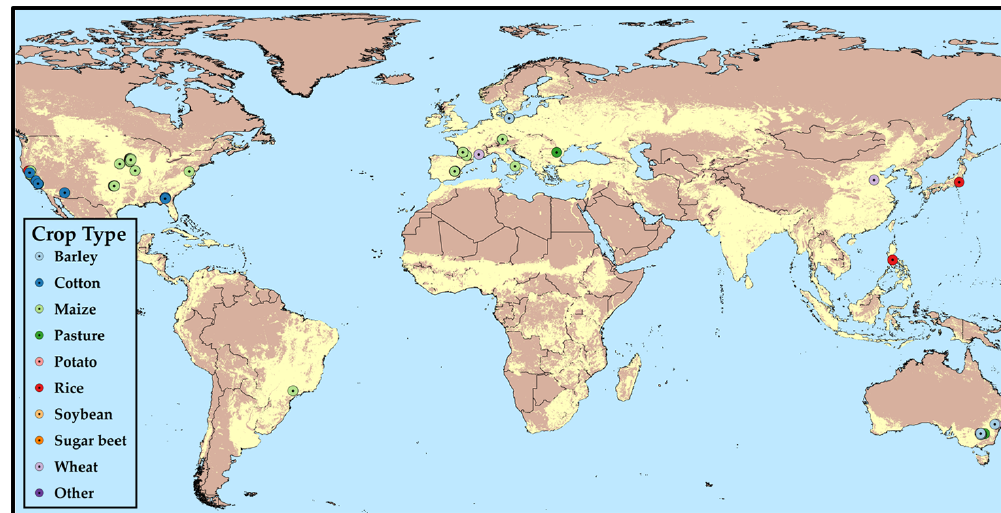
Figure 2. Sites where in situ (destructive or optical) measurements and Landsat Thematic Mapper/The Enhanced Thematic Mapper Plus ground reflectance data were compiled, resulting in more than 1400 data pairs. The sites are overlaid with 1 km grid cells that contain 5% or more crop area (Ramankutty et al.,